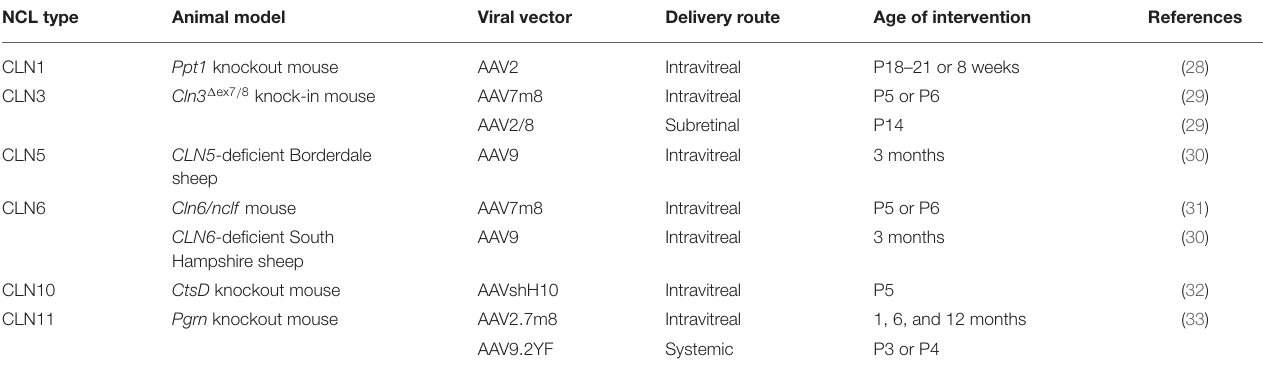
TABLE 2 | Preclinical ocular-targeted gene therapies for